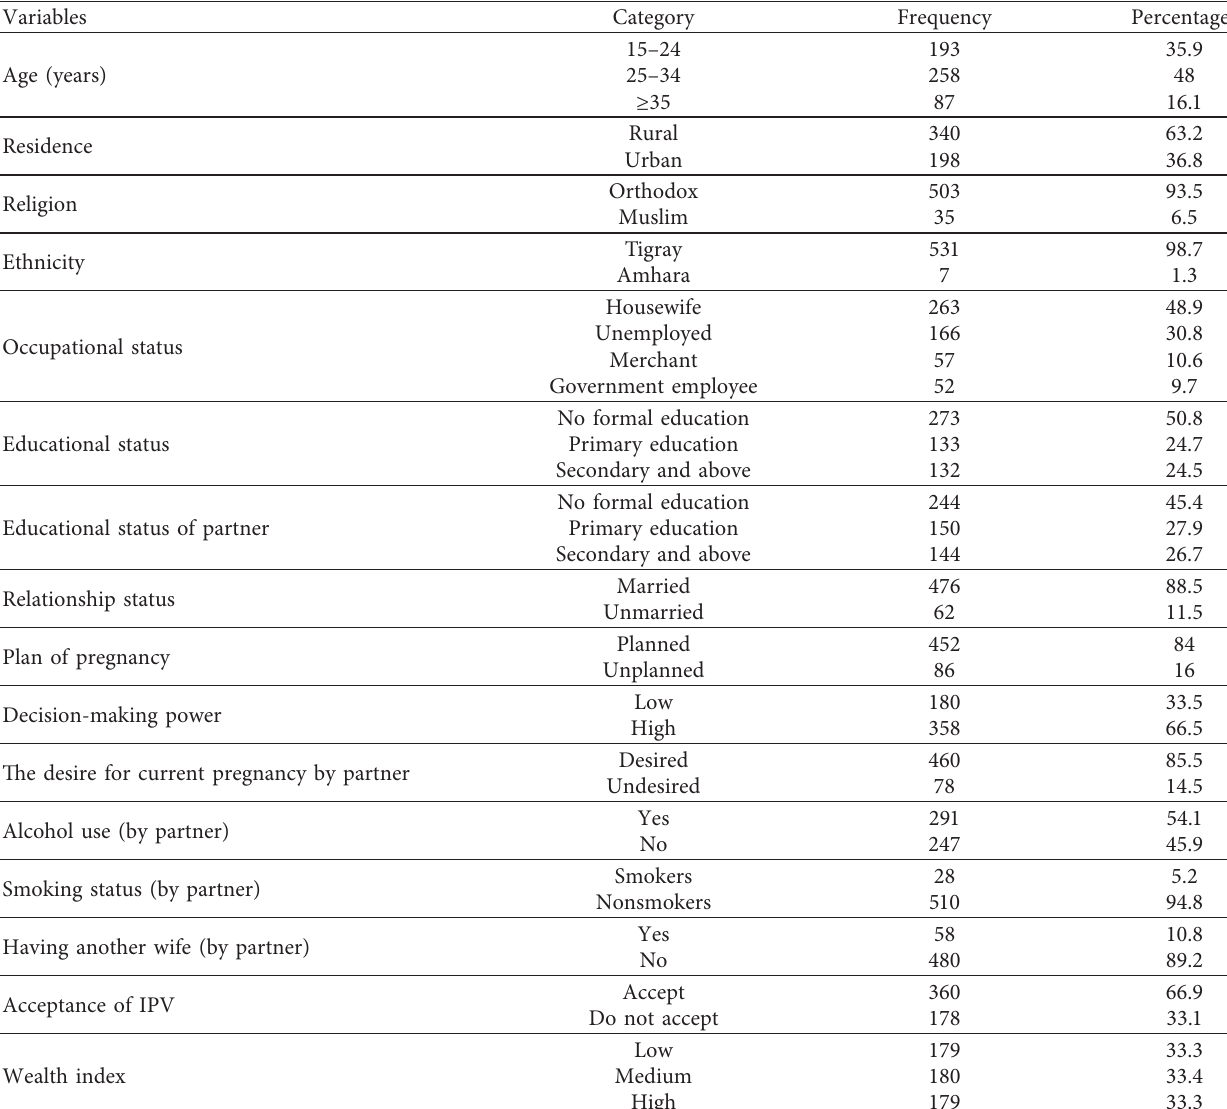
Table 1: Socioeconomic, demographic, and other characteristics of pregnant women and their intimate partners, attending ANC at public health facilities in Ofla District, Tigray, Ethiopia, 2019 ( N �